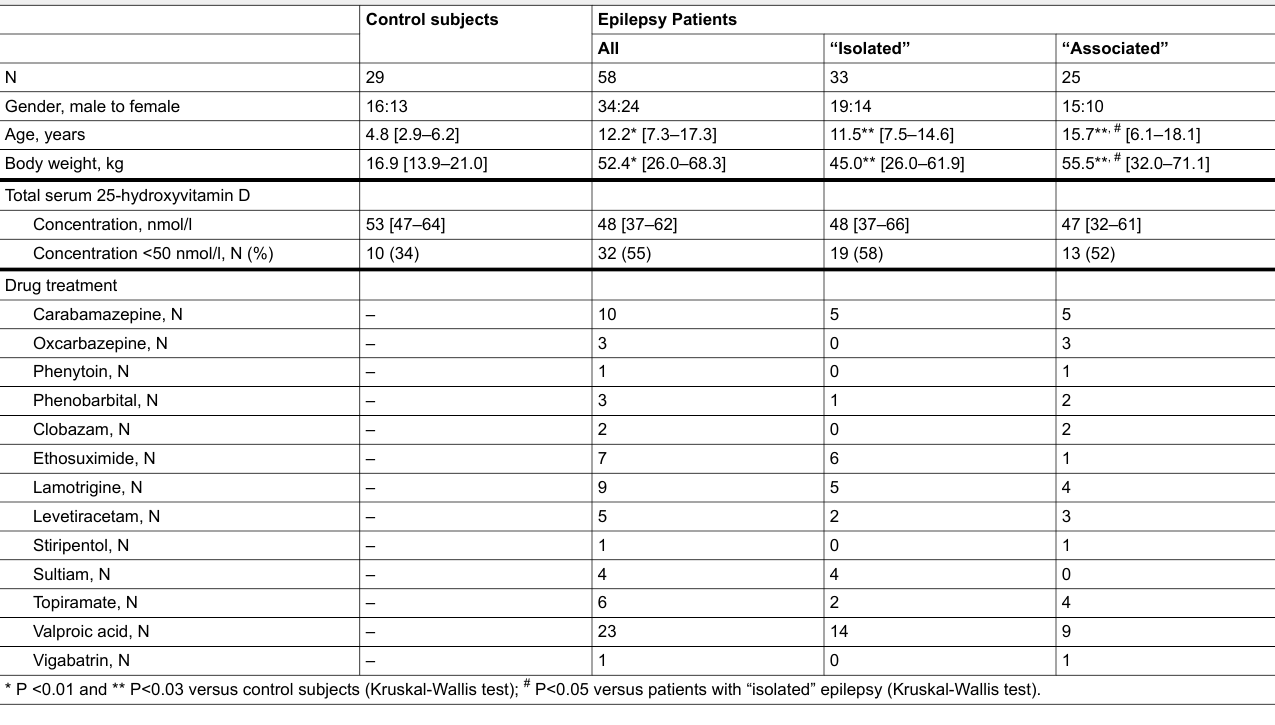
Table 1: Clinical data and antiepileptic drug management in 58 pediatric patients with epilepsy and 29 control patients. Numerical data are presented as median and interquartile range, categorical data as relative frequency.